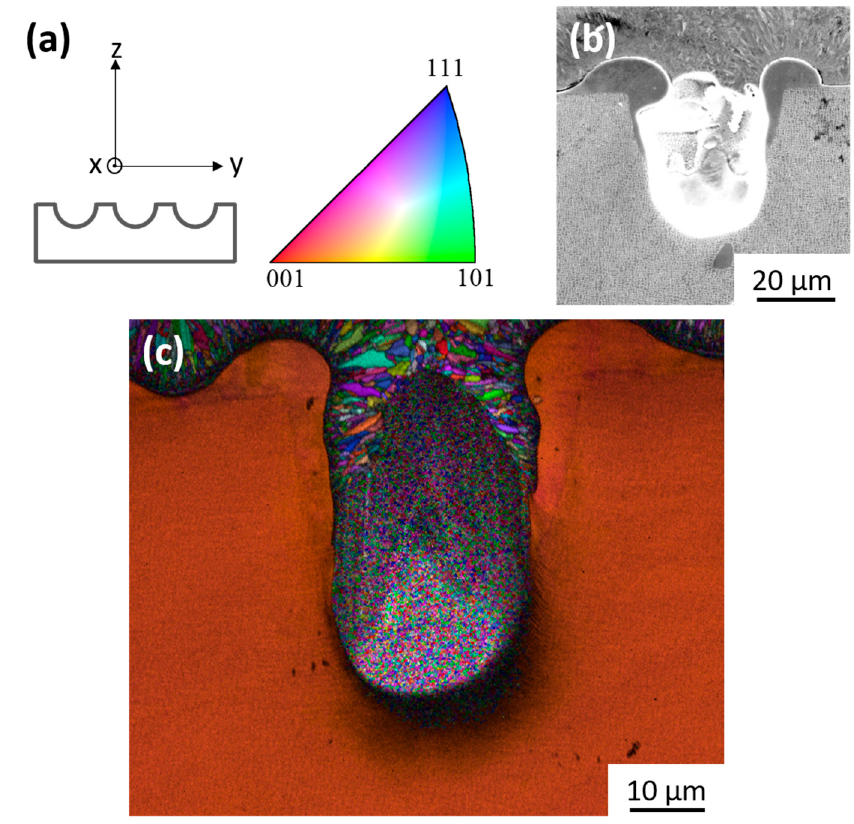
Figure 15. Crystallographic orientation mapping, coded along the z ‐ axis: ( a ) reference frame and inverse pole figure, ( b ) morphology of the considered pattern, ( c ) mapping of the entire pattern. The textured surface of the AM1 was previously nickel plated.